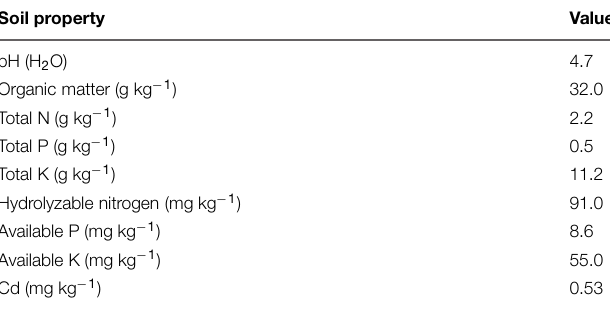
TABLE 1 | Selected physicochemical properties of the soil used in the pot